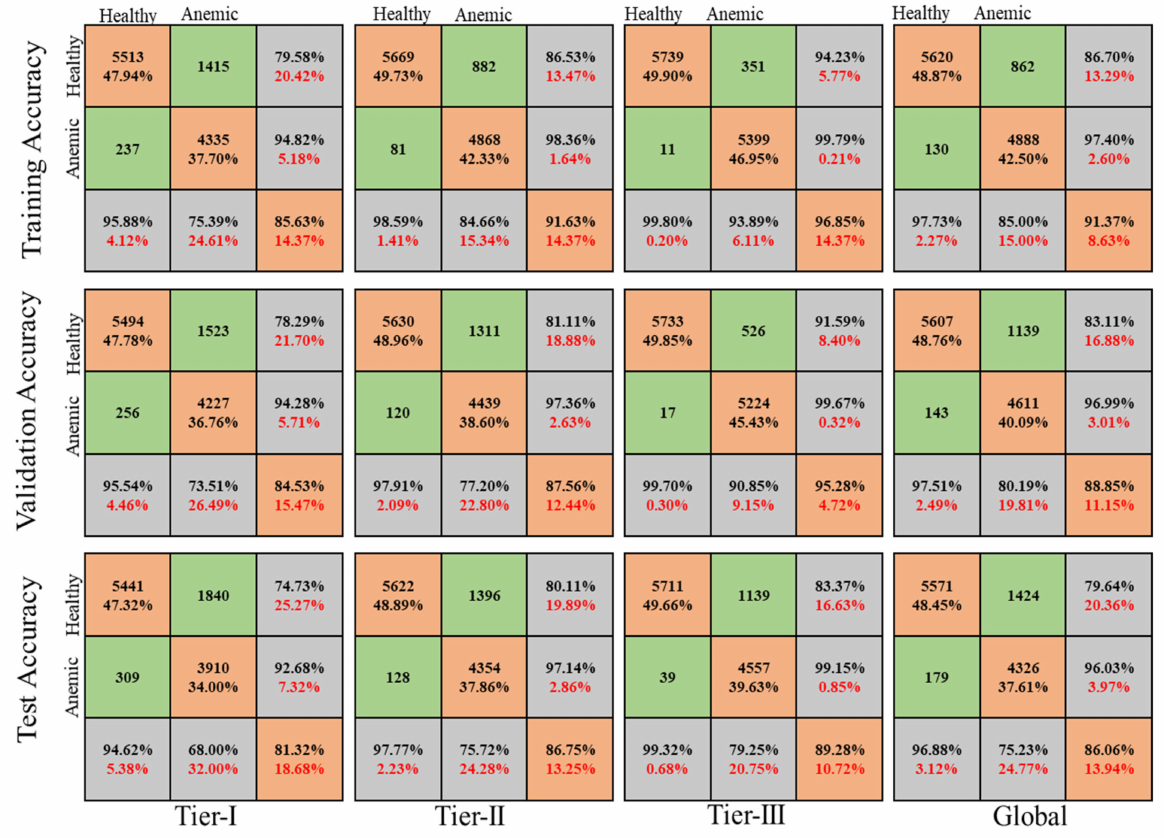
Figure 9. Confusion matrix of training, validation, and testing accuracies of Module-I